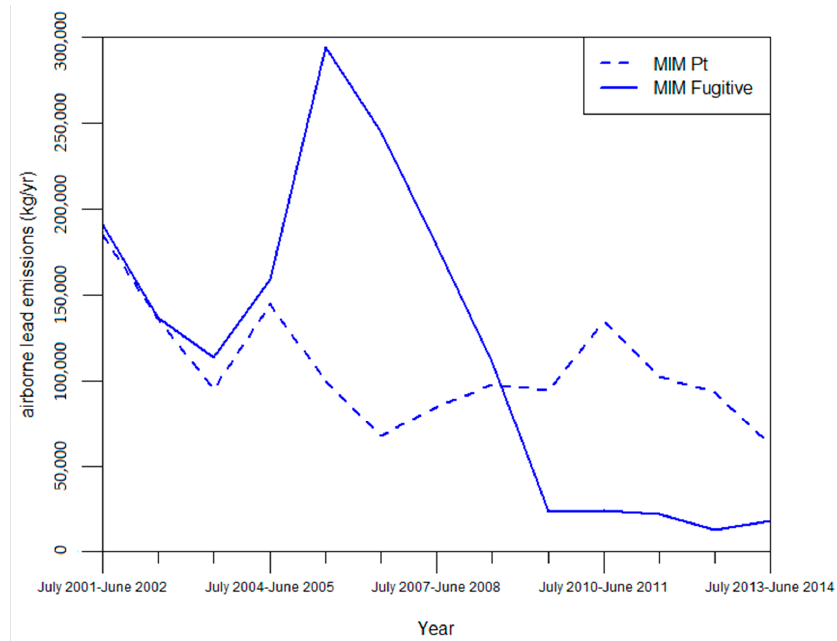
Figure 2. Point and fugitive NPI emission estimates for Mt Isa Mines (MIM)